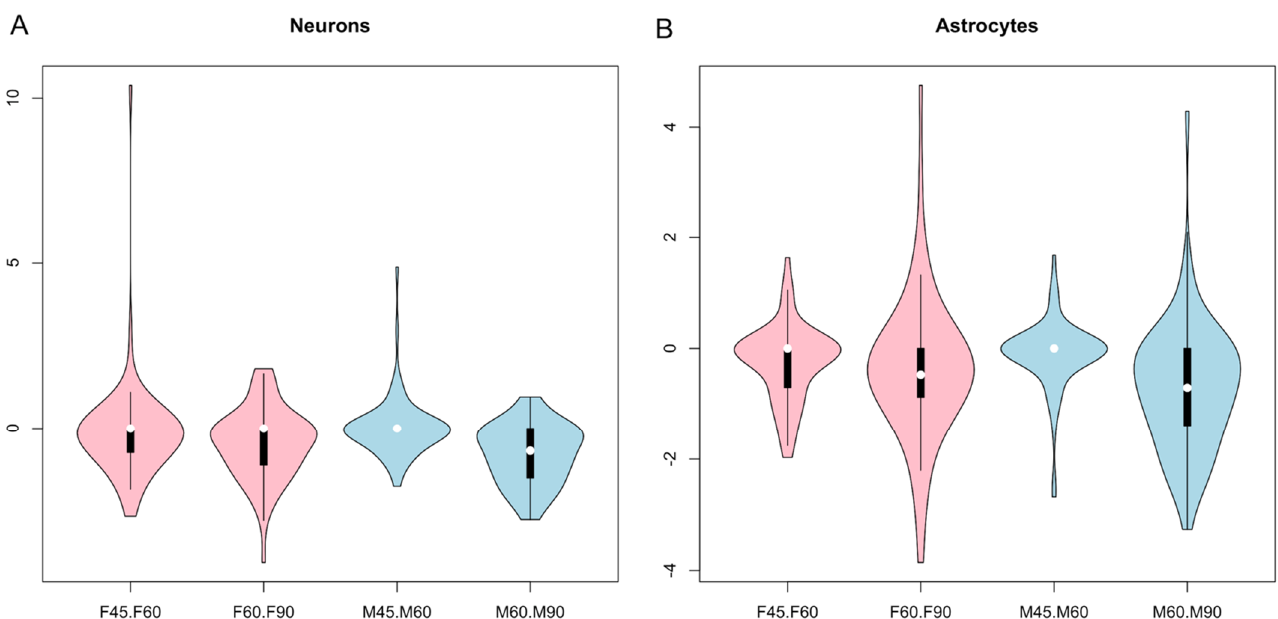
Figure 5. Network plot of genes based on mutation information of expression changes during development of female fetal brain ( A ) and male fetal brain ( B ). The lines (edges) connecting the nodes show how a gene is transcriptionally intercon- nected with other genes. They are colored pink in female brain and blue in male brain.